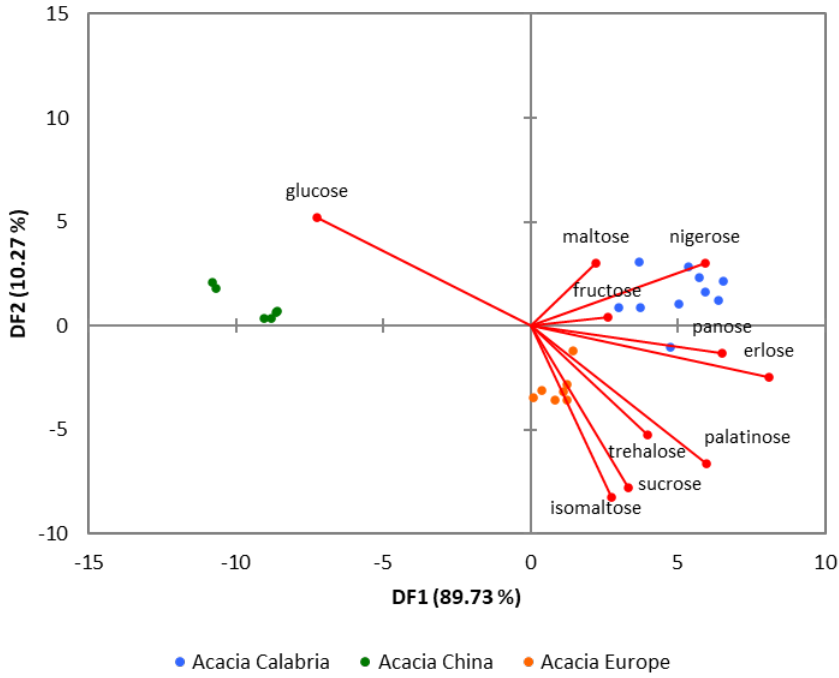
Figure 5. LDA biplot of acacia honeys classified based on their geographical origin.